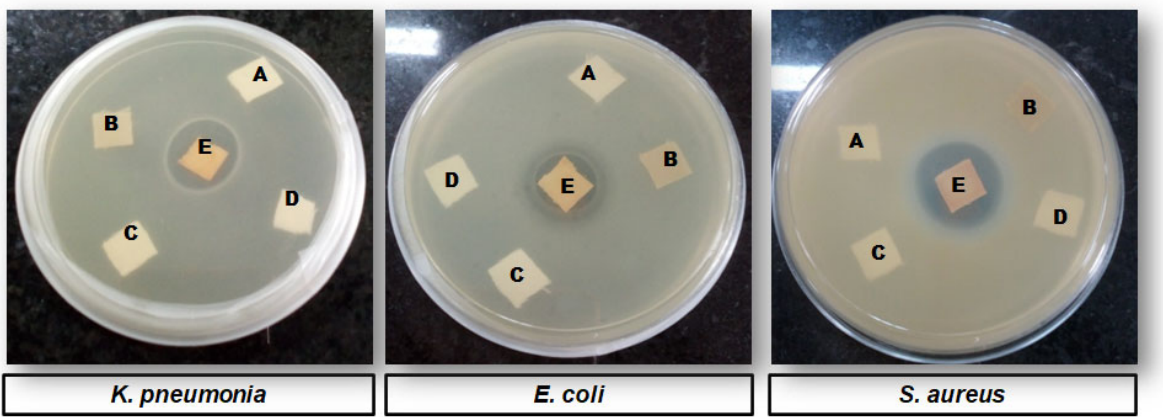
Figure 4. Agar diffusion assay of (1) K. pneumonia (2) E. coli and (3) S. aureus showing ZOI around the Se-coated-30 fabric E where A, B, C and D represent controls: sodium selenite salt, guava extract, uncoated and activated fabric samples, respectively.